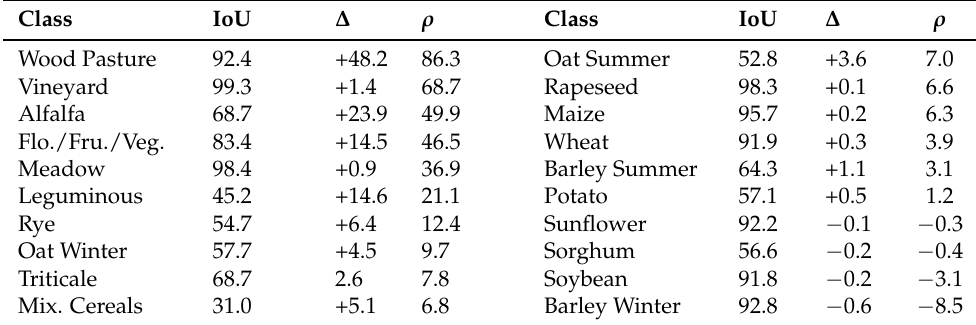
Table 4. Performance by class. IoU per class of our model M dec for the year 2020, as well as the improvement ∆ compared to the single-year model M single , and the ratio of improvement ρ . All values are given in %, and we sort the classes according to decreasing ρ .